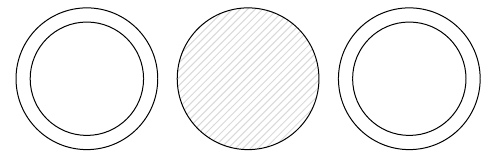
Figure 23. Bubble diagram obtained by joining the external legs with identical colors in figure